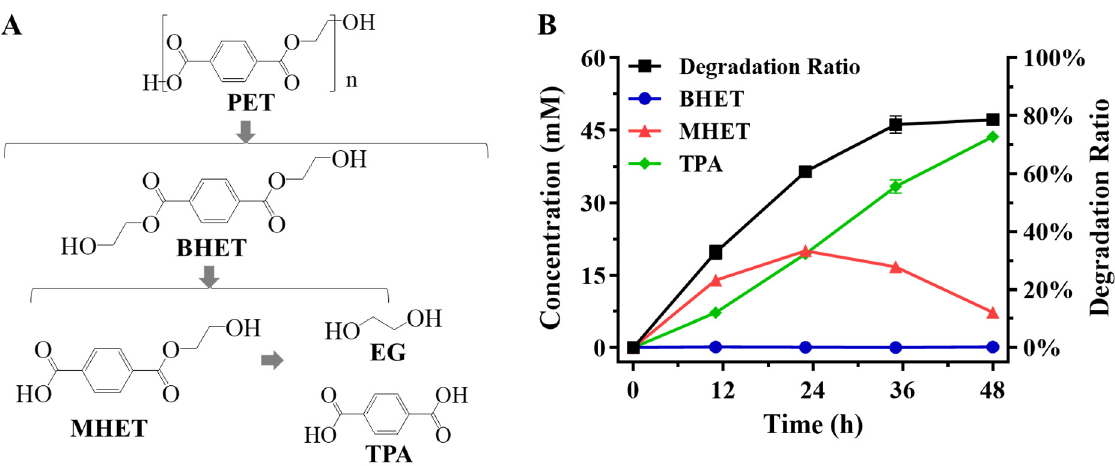
P. putida KT2440-tacRDL.